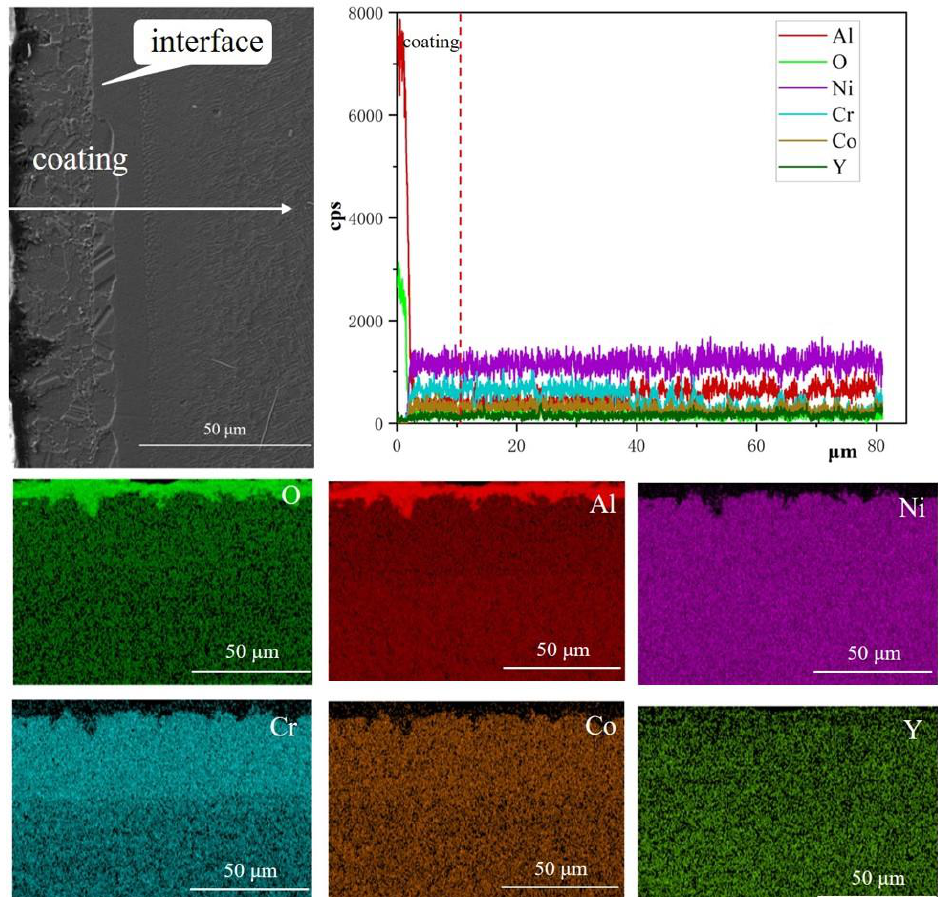
Figure 10. Elemental distribution of the alloys coated with HY5 from the surface to the inside after exposure to high temperatures.